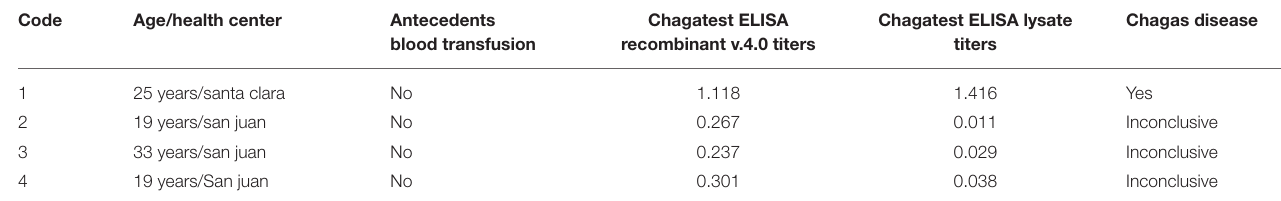
TABLE 2 | Results of two serological procedures in positive